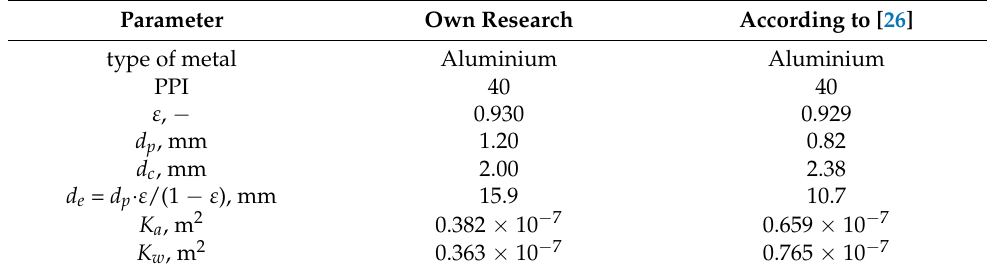
Table 1. Structural parameters of metal